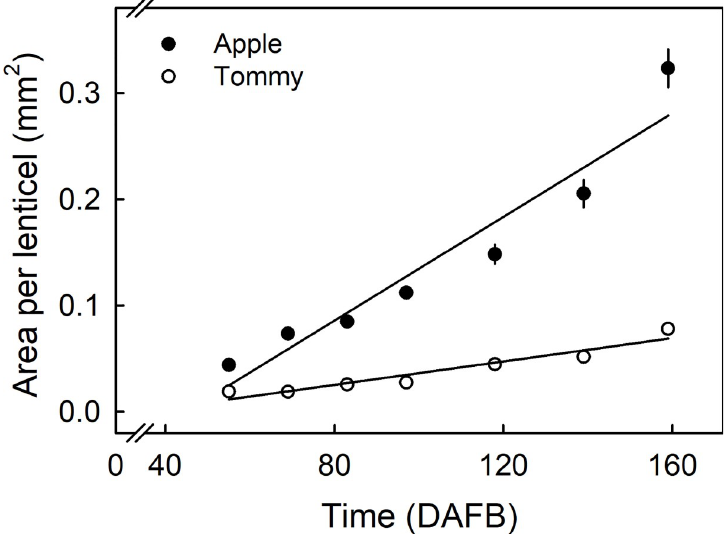
Fig 5. Developmental time course of change in area of lenticels in the cheek region of ‘Apple’ and ‘Tommy Atkins’ mango. The x-axis scale is in days after full bloom (DAFB). Data represent means ± SE. The number of replicates was 60